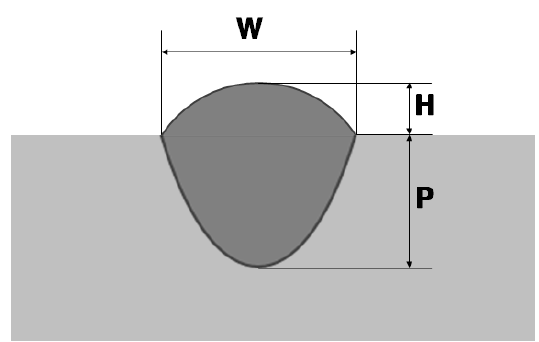
Figure 8. Measurement positions from cross-section observation.